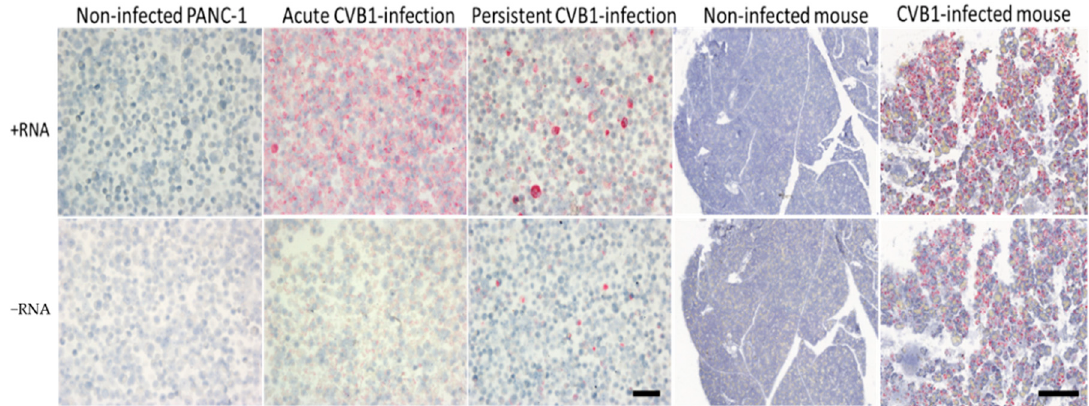
Figure 10. Acutely (1 d.p.i.) and persistently (172 d.p.i.) CVB1-infected pancreatic ductal (PANC-1) cells and acutely (3 d.p.i) CVB1-infected mouse pancreas with respective non-infected controls were para ffi n embedded and stained for + RNA and − RNA using ViewRNA ISH. In the acute infections (cells and mice), both + RNA and − RNA were clearly detected (columns 2 and 5, respectively); however, the expression of + RNA was visibly stronger. Similarly, in persistent infection (column 3), both RNA strands were detected, and again + RNA was more abundant compared to − RNA. Representative images of non-infected cells and mouse pancreas are also shown (columns 1 and 4). These were negative for both RNA strands, as expected. Scale bar 50 µ m in cell samples and 300 µ m in mouse